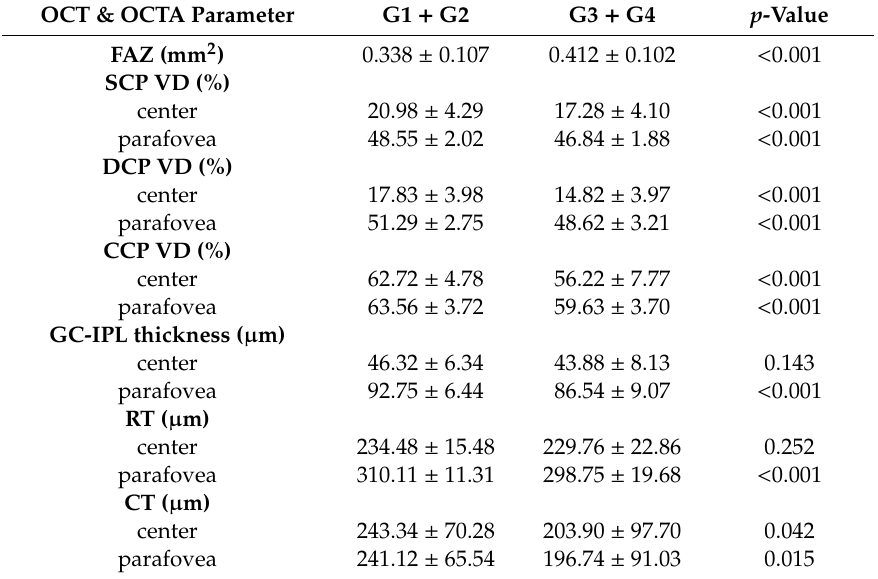
Table 5. Comparison between G1 + G2 and G3 +